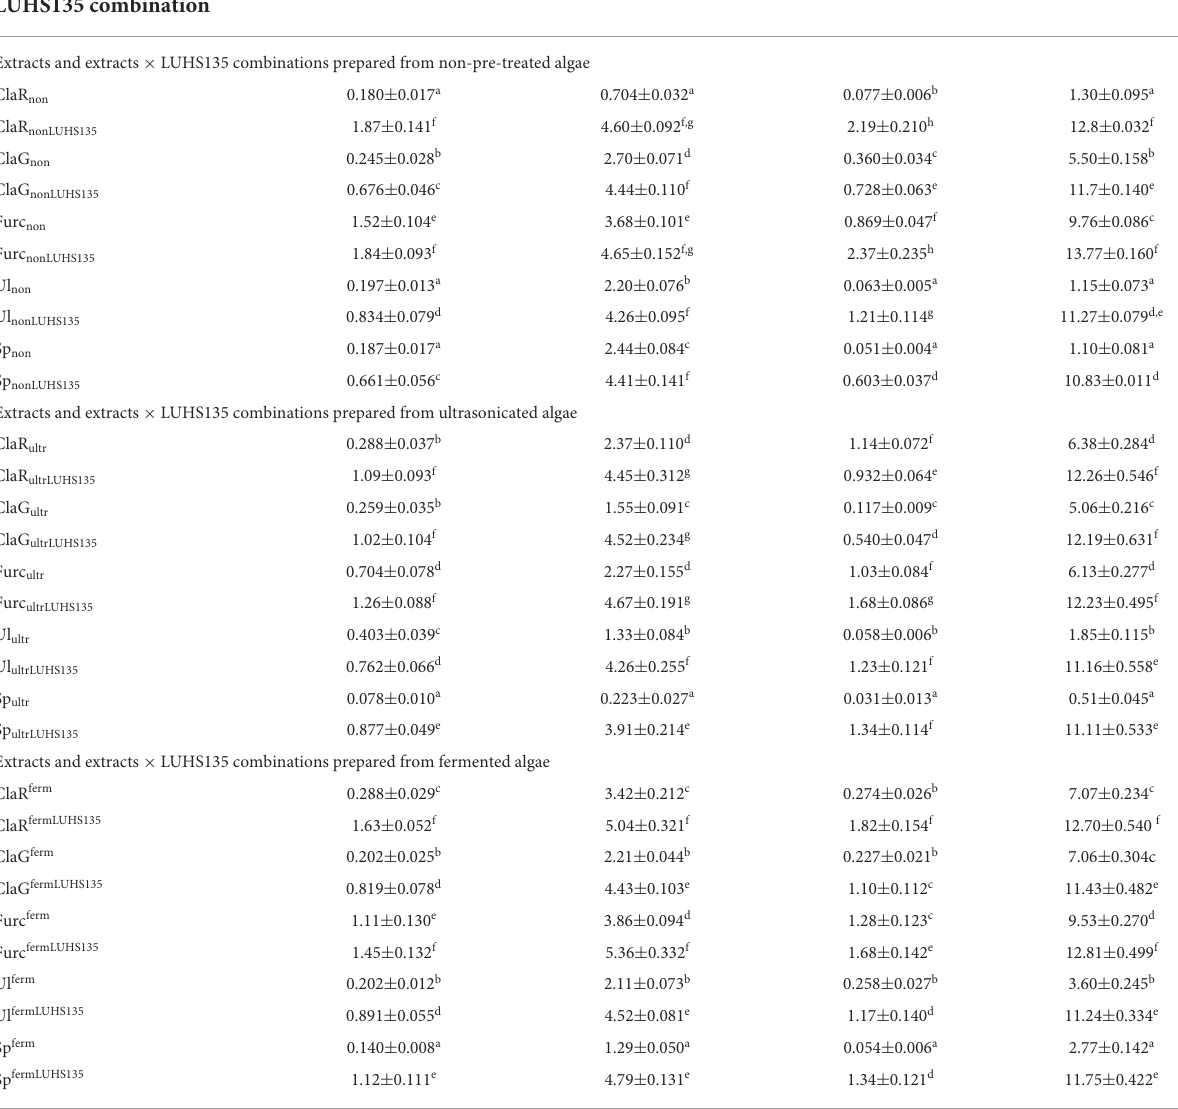
TABLE 3 Antioxidant activities and total phenolic compound content of algae extracts and algae extracts × LUHS135 combinations. Extracts and extract